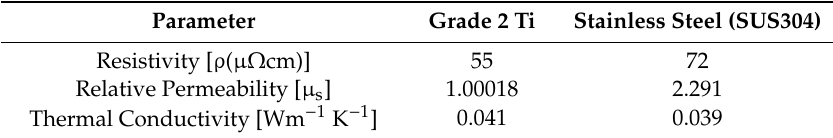
Table 1. Comparison of titanium and stainless